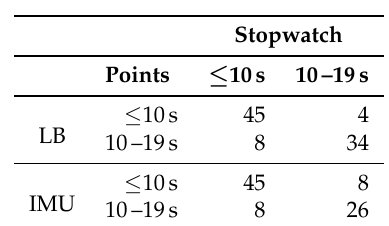
Figure 6. Corresponding Bland–Altman plot. Included levels indicate mean Diff ± 1.96 SD ( − 0.10 to 3.09 s). Table 5. Comparison of the categorization of the cut-off values for the TUG test [16]. All measurement values were adjusted via the corresponding linear regressions and rounded. Since no TUG performance took over 19 s, the additional classes were